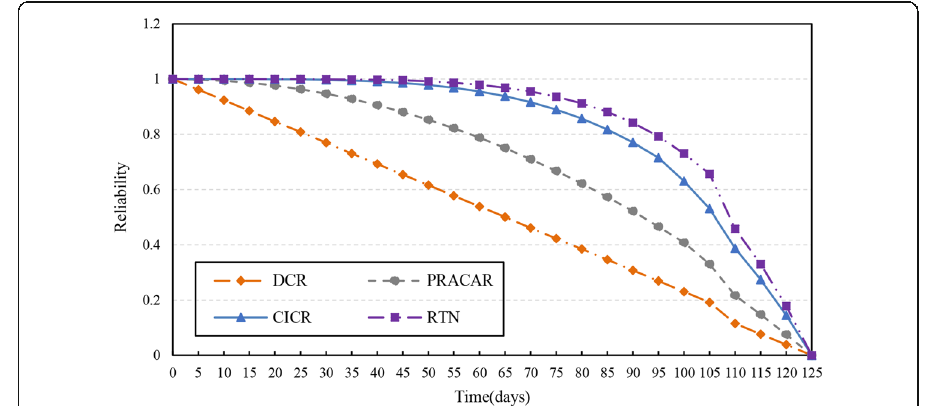
Fig. 13 Reliability of the restored region with four partitions versus